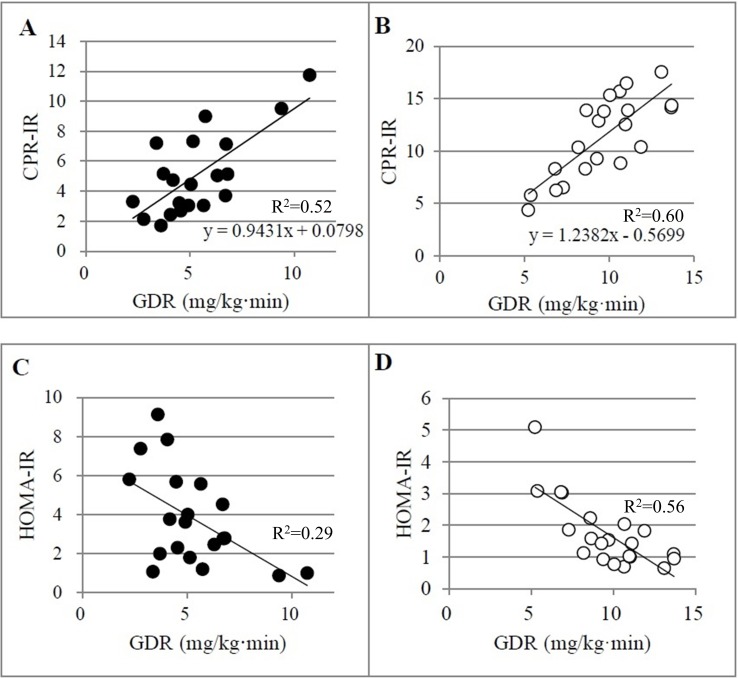
The correlation between the glucose disposal rate (GDR) and C-peptide immunoreactivity insulin resistance (CPR-IR; A, B) or homeostasis model assessment of insulin resistance (HOMA-IR; C, D), where black circles depict results from study participants with type 2 diabetes mellitus and white circles depict results from study participants without diabetes.